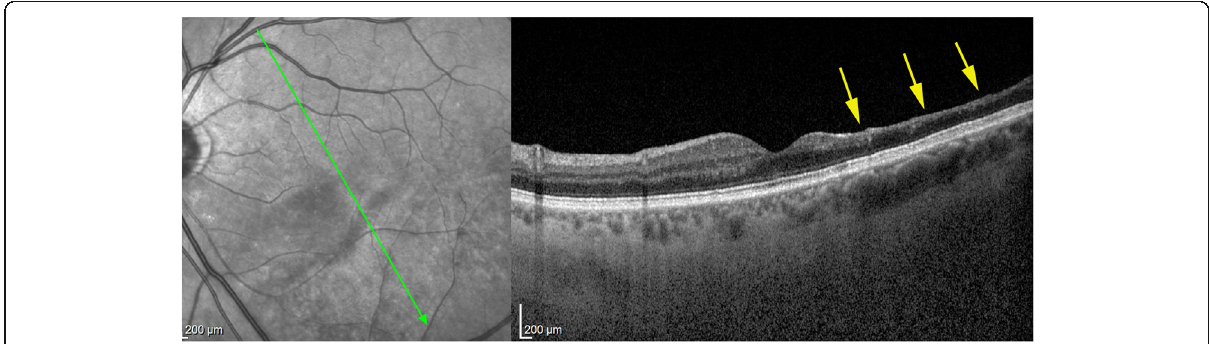
Fig. 1 Six weeks after presentation the ischaemic zone resulted in atrophy the of the inner retina; shown by OCT imaging (arrow); note that photoreceptor outer segment ellipsoid zone is conserved (case